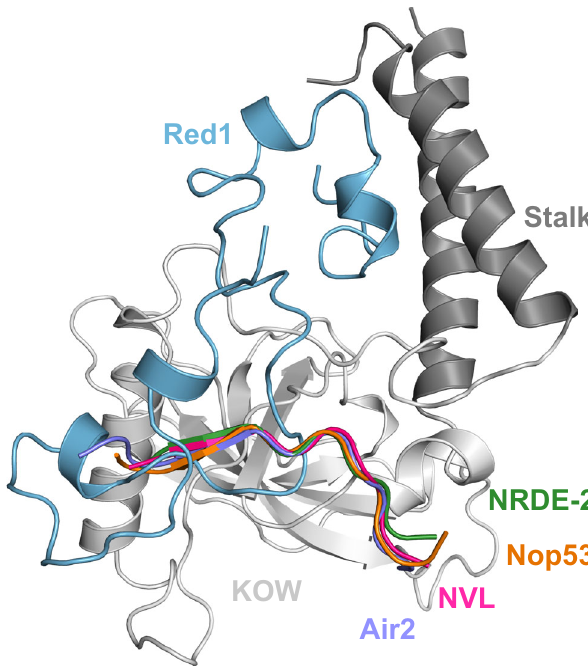
Fig. 7 Comparison of the ct Mtr4 – ct Red1 crystal structure with known Mtr4 complexes. Crystal structure of the ct Mtr4 SA – ct Red1 pep complex (Red1 in blue, stalk helices in dark gray and KOW domain in light gray) is superimposed with the structures of Mtr4-Air2 (PDB: 4U4C 33 ,violet), Mtr4-NVL (PDB: 6RO1 (ref. 34 ), pink), Mtr4-Nop53 (PDB: 5OOQ 35 , orange), and hMTR4-NRDE-2 (PDB: 6IEH 36 , green). For simplicity only the Mtr4 interacting peptides of these complexes are shown. A detailed comparison is shown in Supplementary Fig.